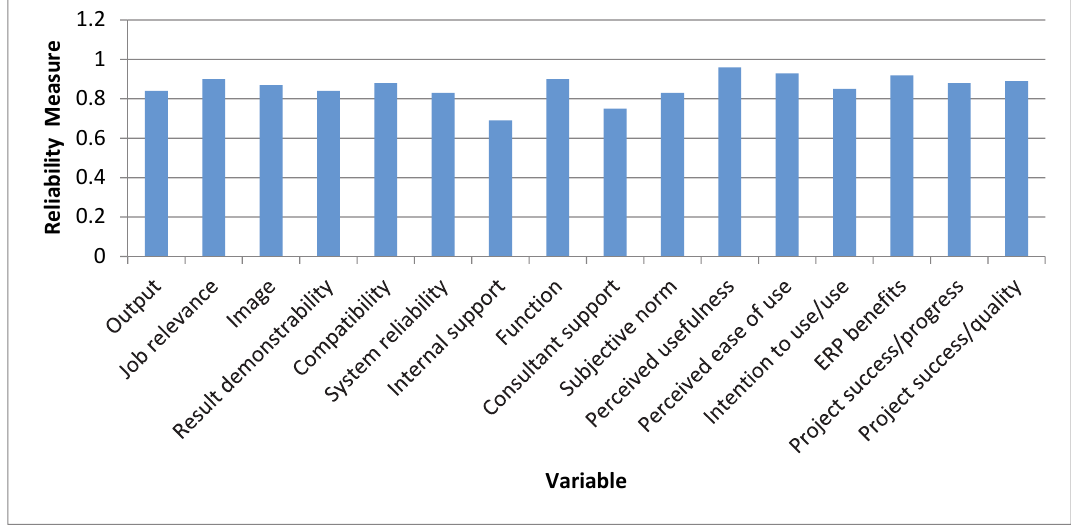
Fig. 3. Reliability measure associated ERP implementations against different